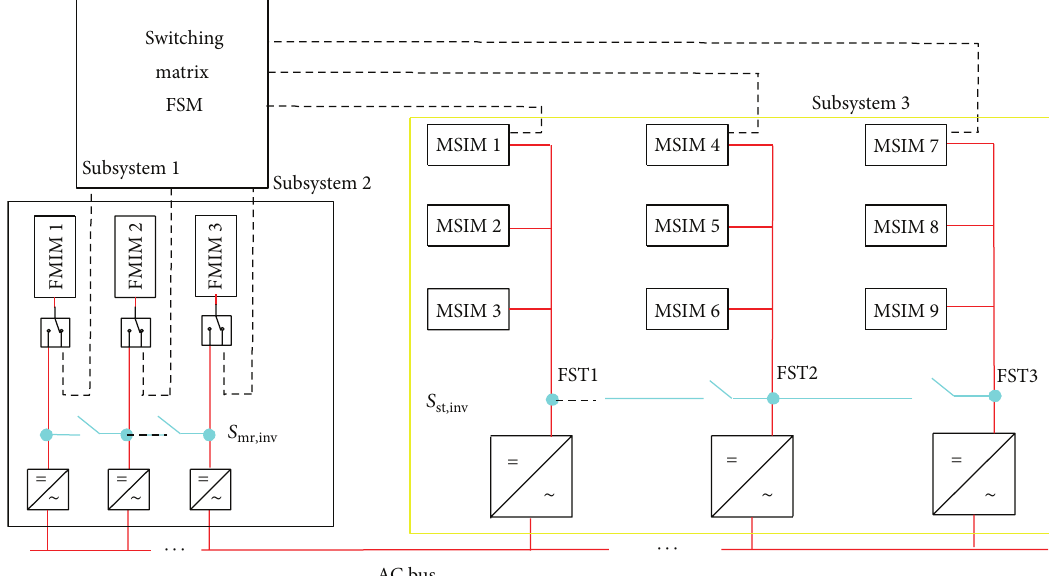
Figure 1: Layout of the adaptive PV string-inverter configuration with three flexible strings (FST) forming the MSIM and three microinverter modules